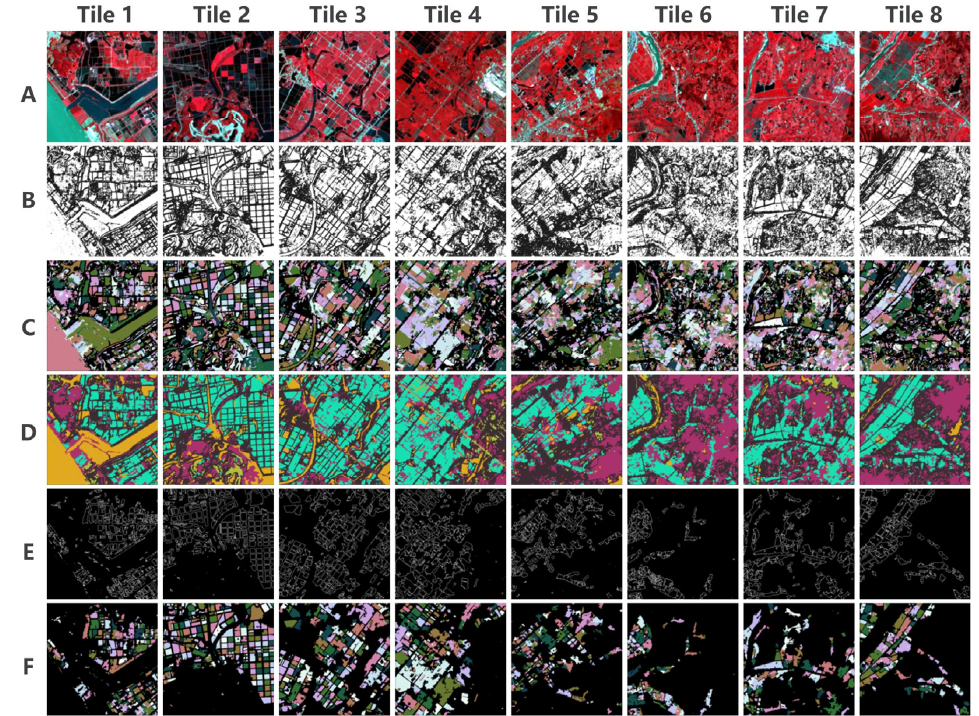
Figure 8. Cropland parcel extraction results derived at different processing steps for eight test tiles. ( A ) Pseudo-color composite imagery of each tile; ( B ) the coarse segmentation results, with the homogenous regions denoted by the white color; ( C ) the fine segmentation results, indicated by the use of a random color for each object; ( D ) the object-based classification results derived using the trained random forest model (the generated croplands are shown with a cyan color); ( E ) the extracted boundaries (white lines) of the final cropland parcels; and ( F ) the final cropland parcels denoted by random colors.